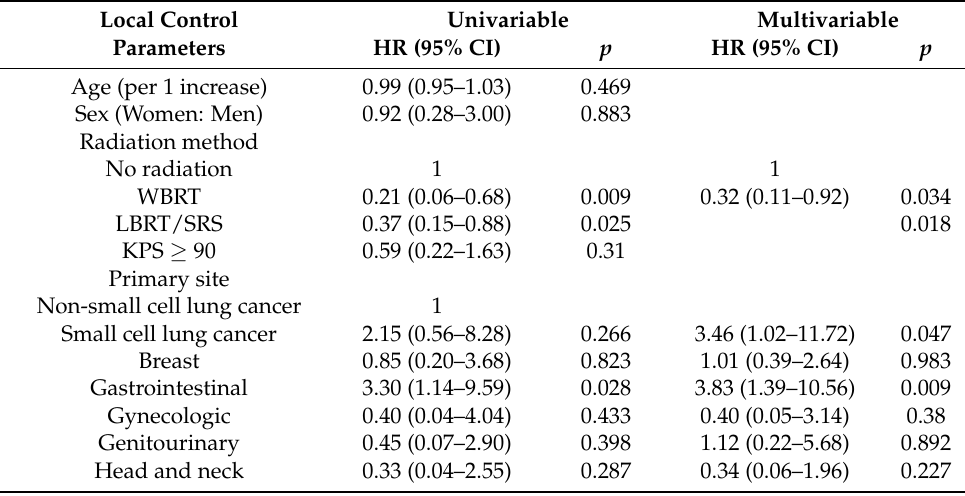
Table 3. Univariable and multivariable Cox regression for local